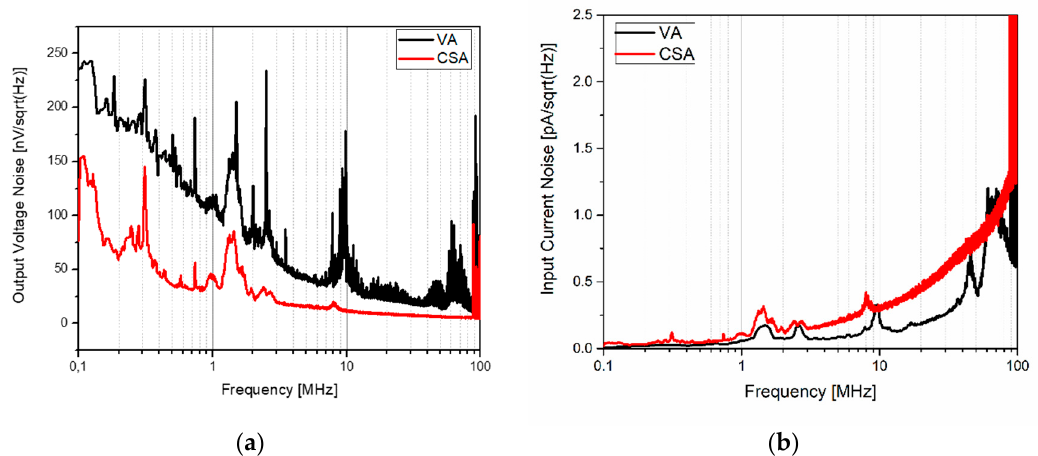
Figure 15. Measured spectral density noise: ( a ) output-referred voltage noise and ( b ) input-referred current noise.